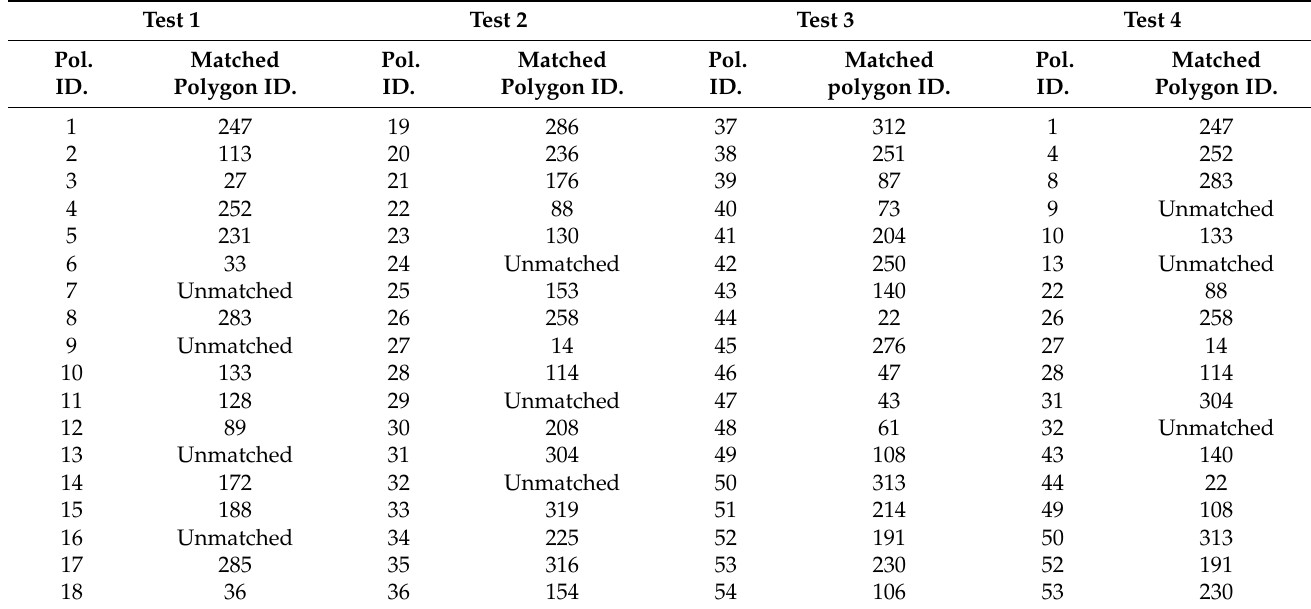
Table A4. Results provided by the GA. Matching experiment.